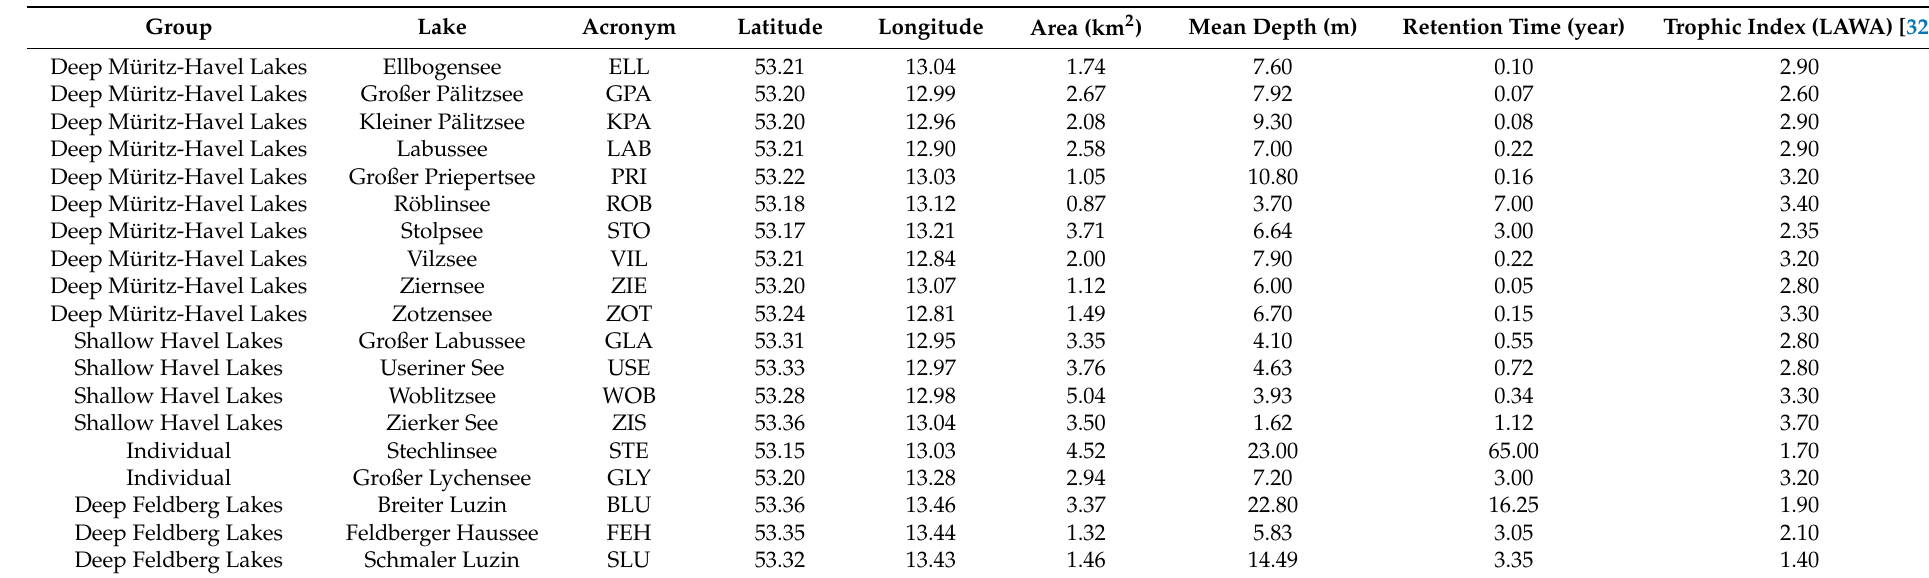
Table 1. Morphometric characteristics, sampling coordinates and trophic index [32] of the studied lakes. Data were kindly provided by the Ministry of Agriculture and the Environment Mecklenburg-Vorpommern. Data for the lakes in Brandenburg are available online